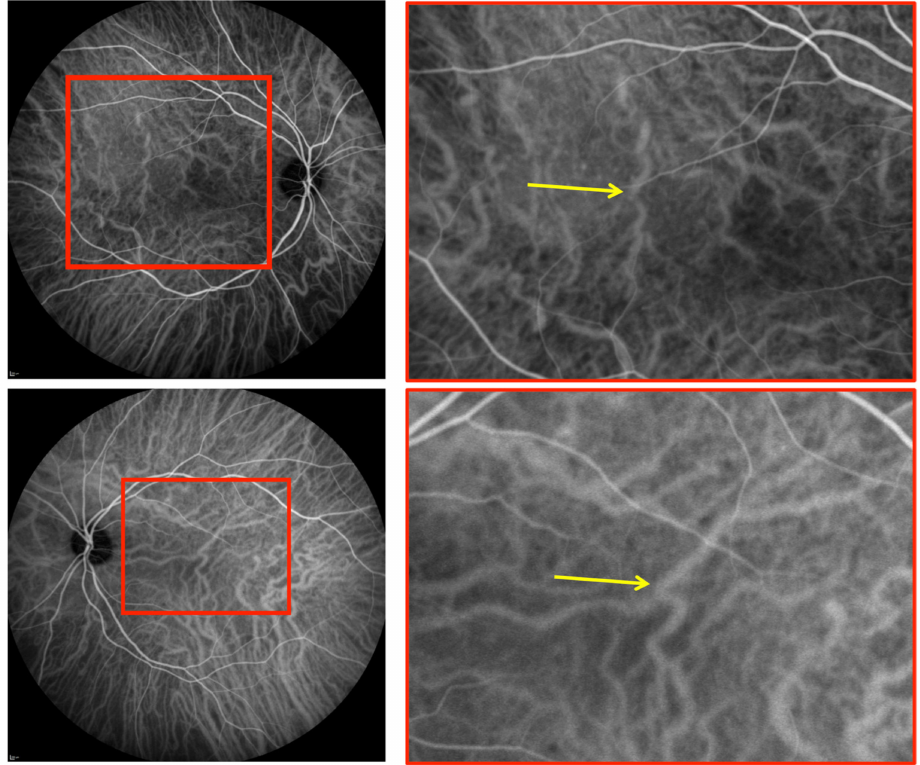
Figure 3. Indocyanine green angiography showing intervortex shunt (yellow arrows) between the superotemporal and inferotemporal vortex vein